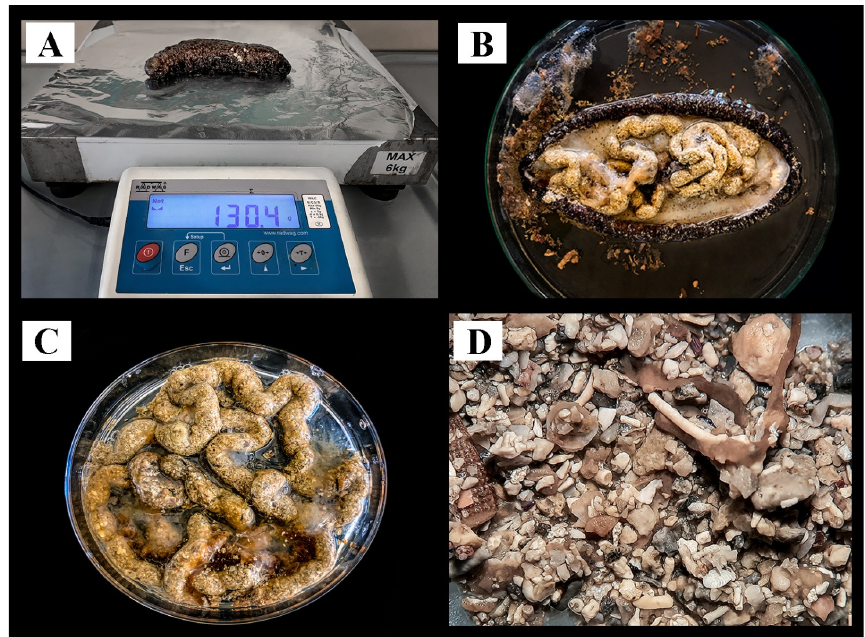
Figure 4. Anatomical dissections. ( A ) H. tubulosa individual on the scale for quantifying weight. ( B ) Longitudinal incision of a sea cucumber. ( C ) The entire digestive system extracted from an individual. ( D ) Detail of the debris found in the gut contents.